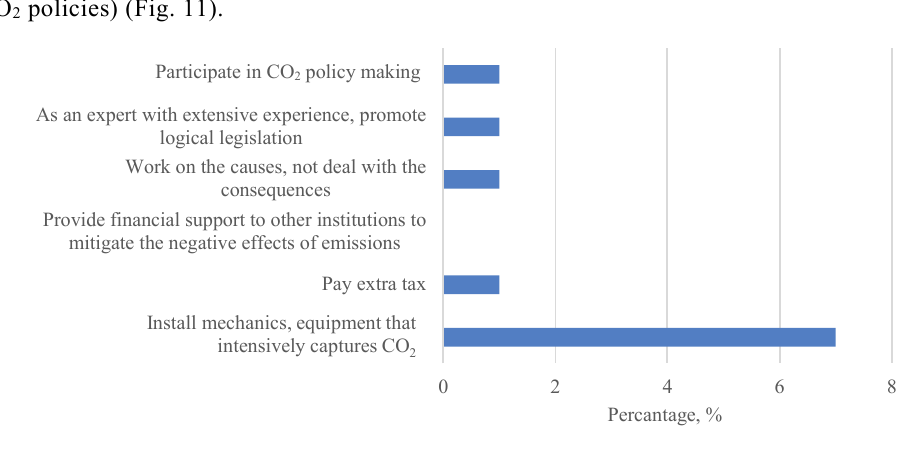
Fig. 11. Possible ways to reduce CO 2 emissions by